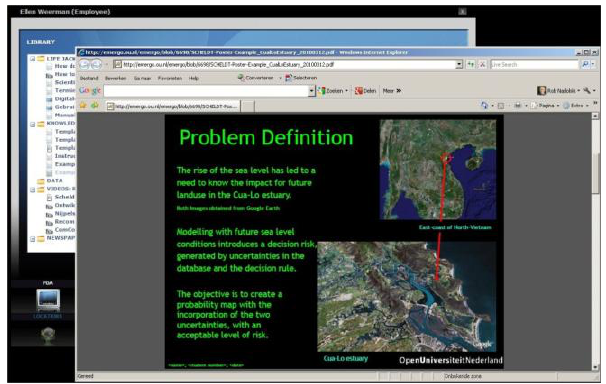
Figure 2: Consulting resources during carrying out a